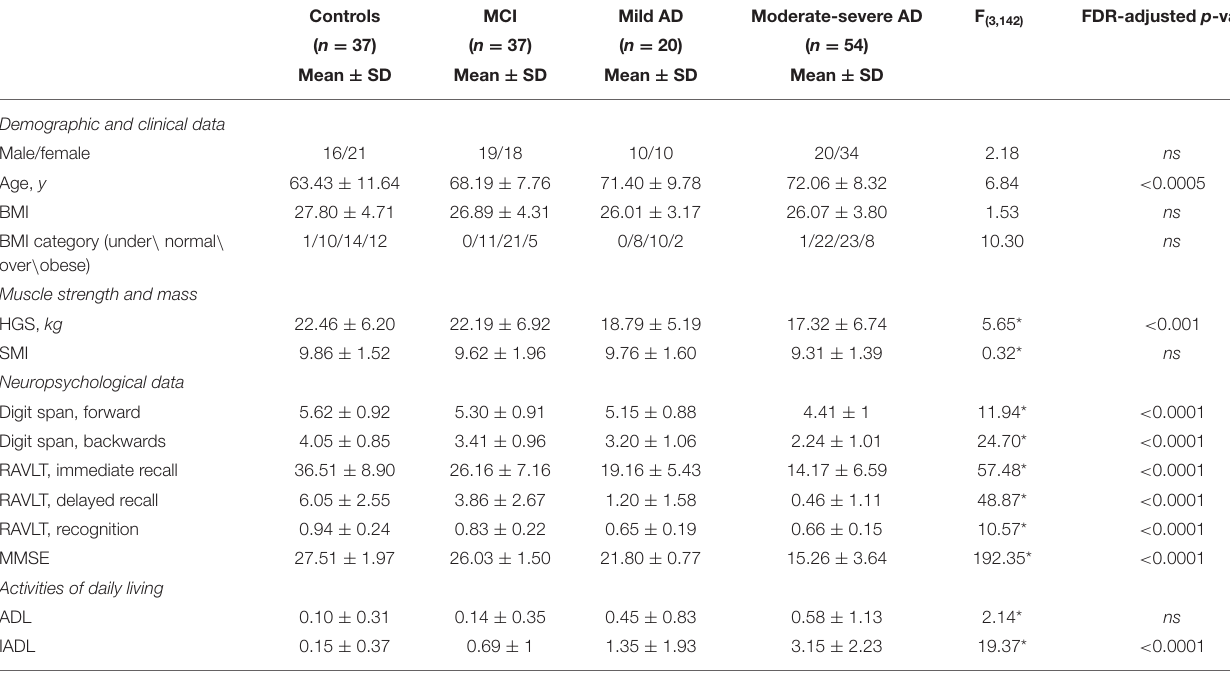
TABLE 1 | Demographic, clinical characteristics, and neuropsychological data.